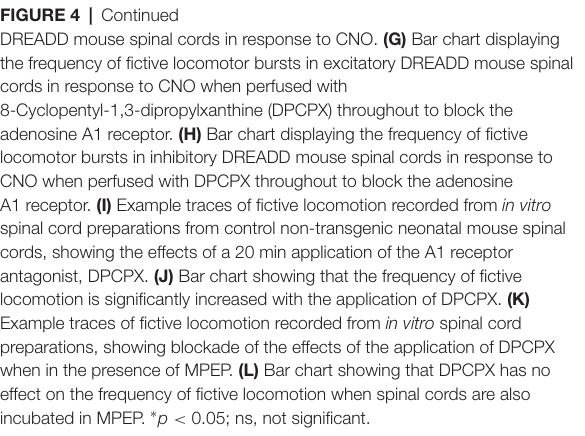
FIGURE 4 | Continued DREADD mouse spinal cords in response to CNO. (G) Bar chart displaying the frequency of fictive locomotor bursts in excitatory DREADD mouse spinal cords in response to CNO when perfused with 8-Cyclopentyl-1,3-dipropylxanthine (DPCPX) throughout to block the adenosine A1 receptor. (H) Bar chart displaying the frequency of fictive locomotor bursts in inhibitory DREADD mouse spinal cords in response to CNO when perfused with DPCPX throughout to block the adenosine A1 receptor. (I) Example traces of fictive locomotion recorded from in vitro spinal cord preparations from control non-transgenic neonatal mouse spinal cords, showing the effects of a 20 min application of the A1 receptor antagonist, DPCPX. (J) Bar chart showing that the frequency of fictive locomotion is significantly increased with the application of DPCPX. (K) Example traces of fictive locomotion recorded from in vitro spinal cord preparations, showing blockade of the effects of the application of DPCPX when in the presence of MPEP. (L) Bar chart showing that DPCPX has no effect on the frequency of fictive locomotion when spinal cords are also incubated in MPEP. ∗ p < 0.05; ns, not